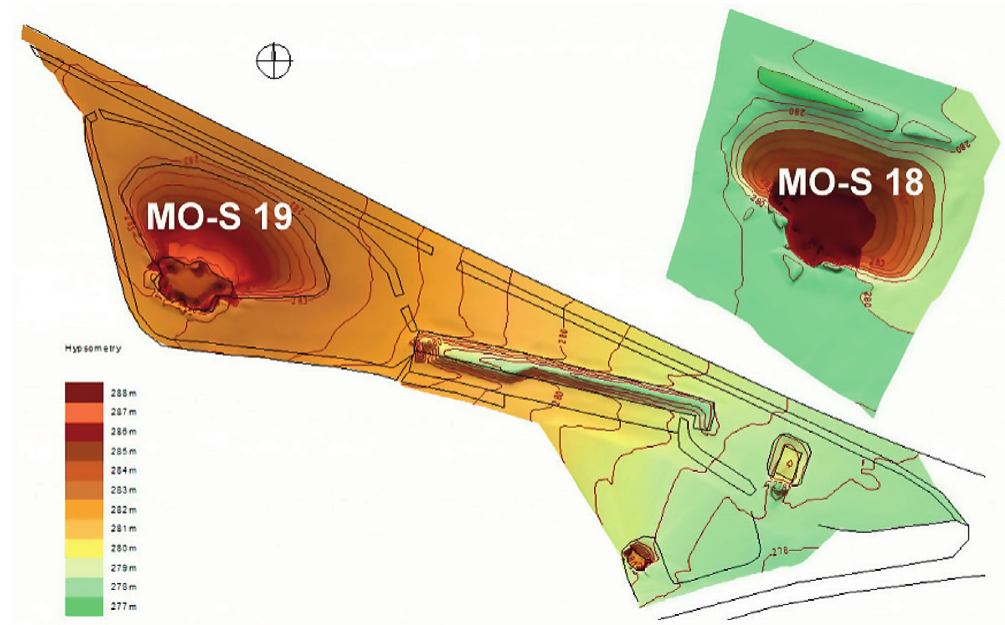
Fig. 8. MO-S 18, MO-S 19, digital terrain